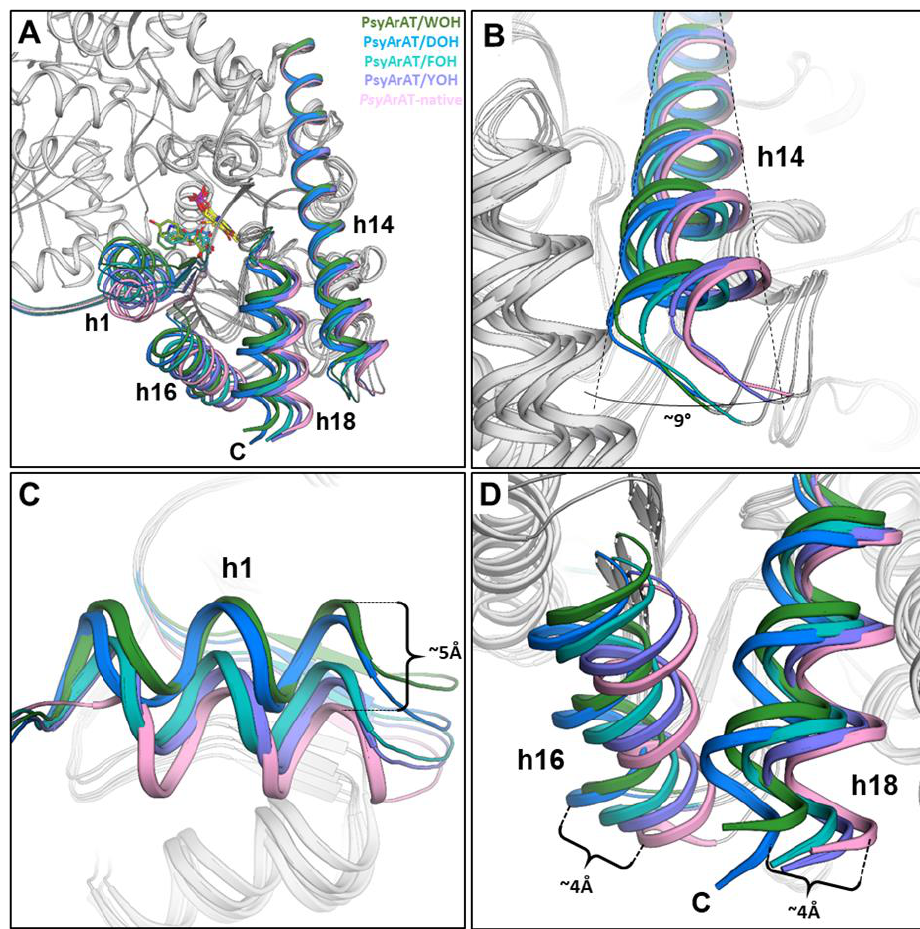
Figure 9. Psy ArAT domains ’ motion during ligand binding. Overall view of the aligned structures ( A ); Kink of the long helix h14 ( B ); the motion of the helix h1 ( C ); Synchronic movement of the helix h16 and h18 ( D ). Values of domain movement are in Table 2.